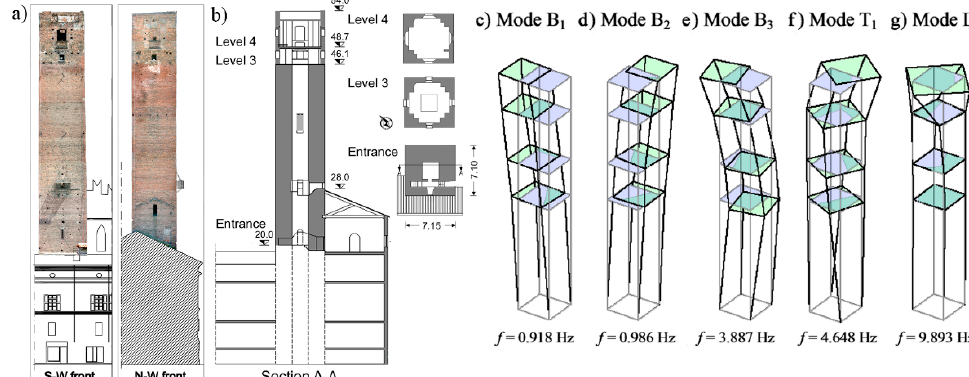
Figure 6. Gabbia Tower in Mantua. ( a ) Fronts and ( b ) section of the Tower. The last identified modes involve deflections of the upper portion of the tower, evidence of the structural effect of the surveyed changes of the structural layout, masonry quality and morphology [19] ( f: frequency).